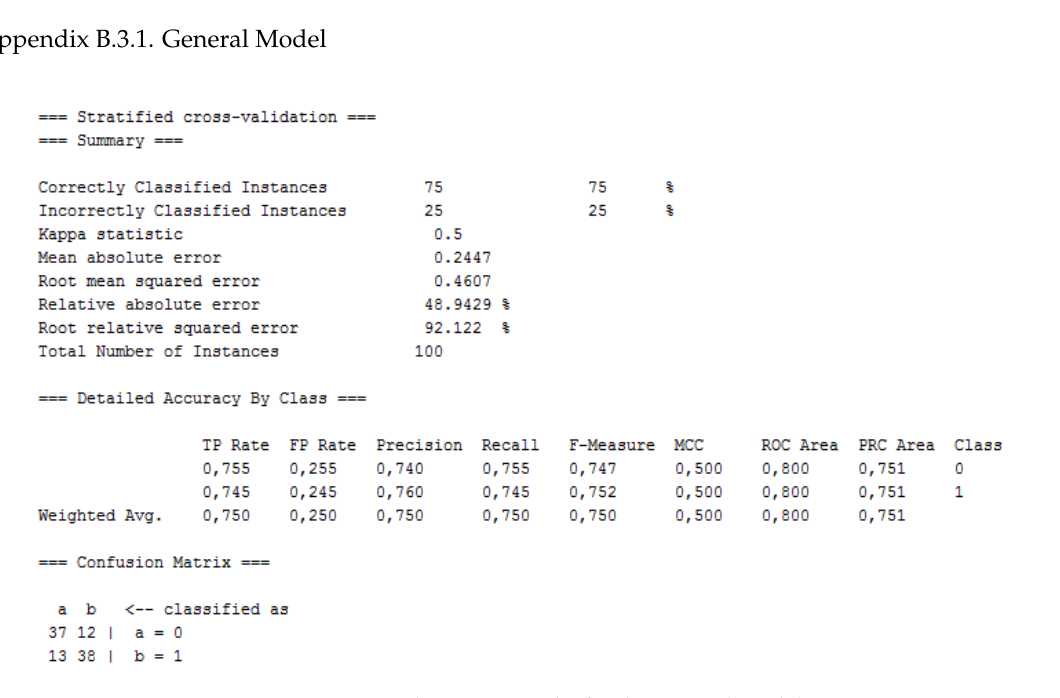
Figure A7. Random Tree Results for the General